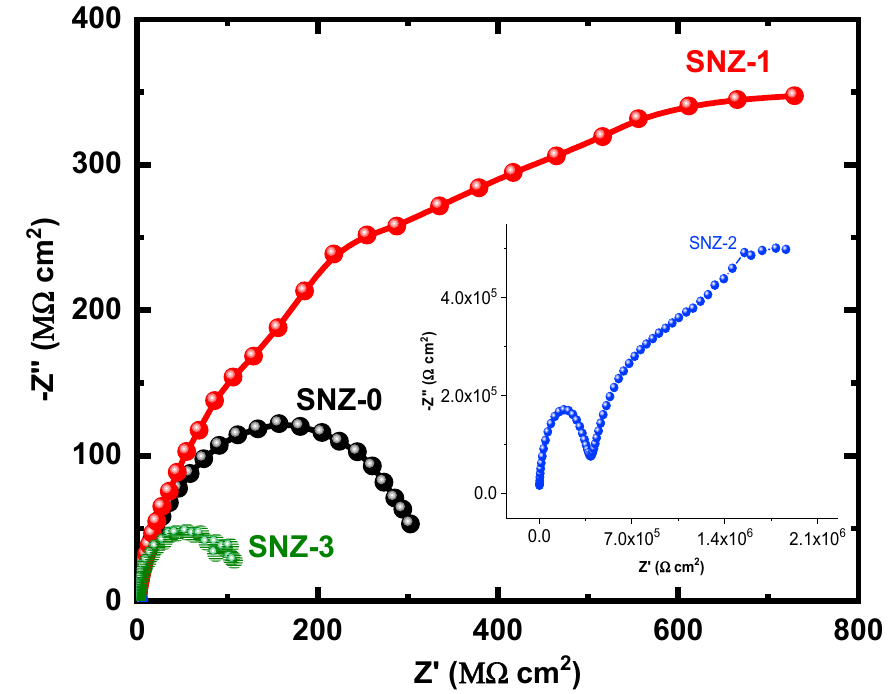
Figure 7. Nyquist plots of the coatings after 15 days’ immersion in a 3.5% NaCl solution .